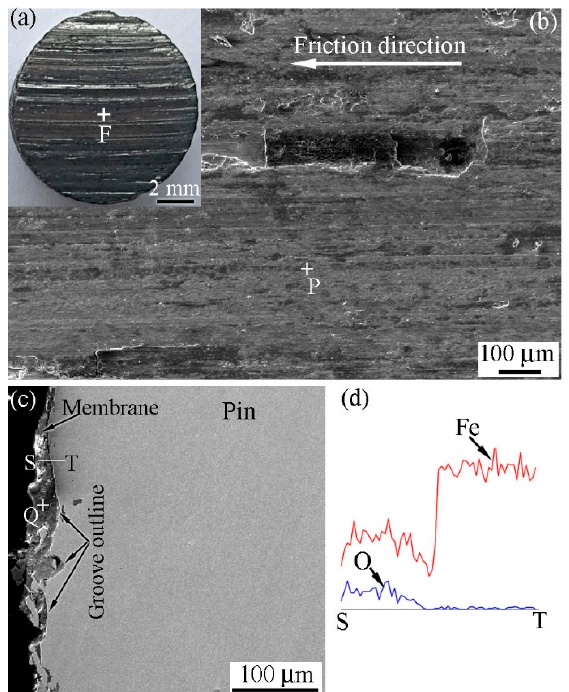
Figure 12. Features of the worn pin surface when the RD was not used; H = 26.1 × 10 3 A/m. ( a ) Macro-photograph; ( b ) SEM image of the worn surface; ( c ) SEM image of the cross section; and, ( d ) energy spectrum analyzer (EDS) results along the ST line. T able 2 Chemical components of the worn surface (at.%).